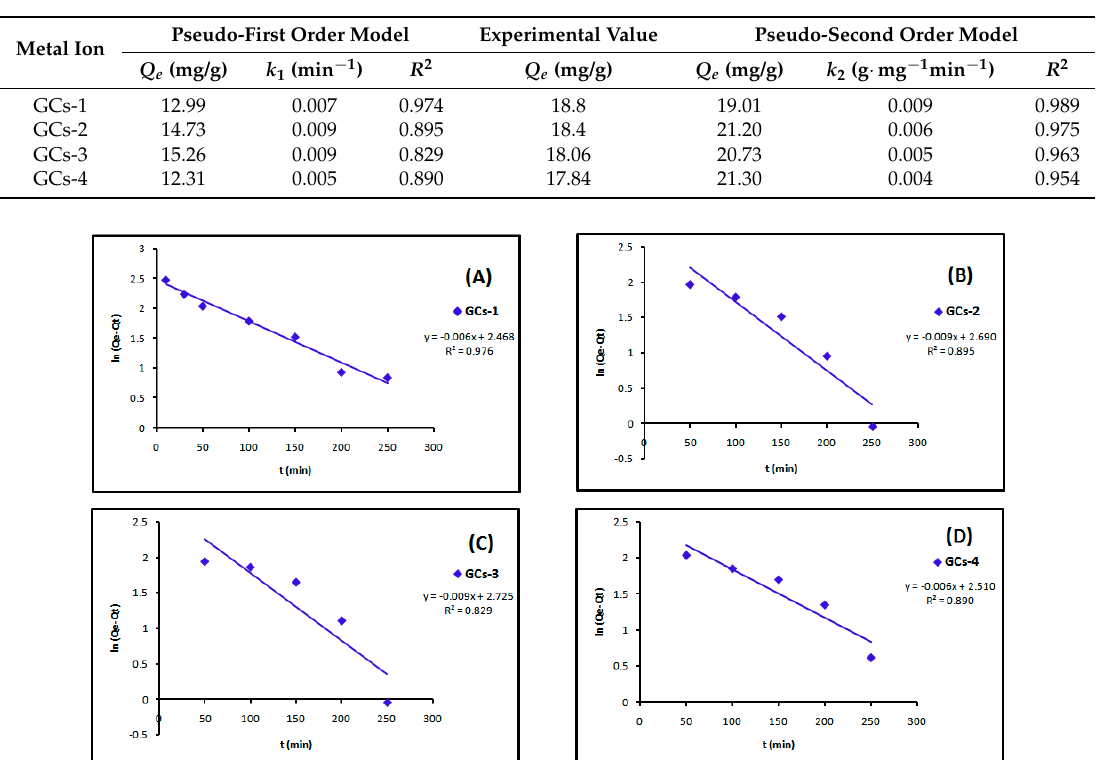
Figure 13. Pseudo-first order kinetics models of copper adsorption using ( A ) GCs-1, ( B ) GCs-2, ( C ) GCs-3 and ( D ) GCs-4.